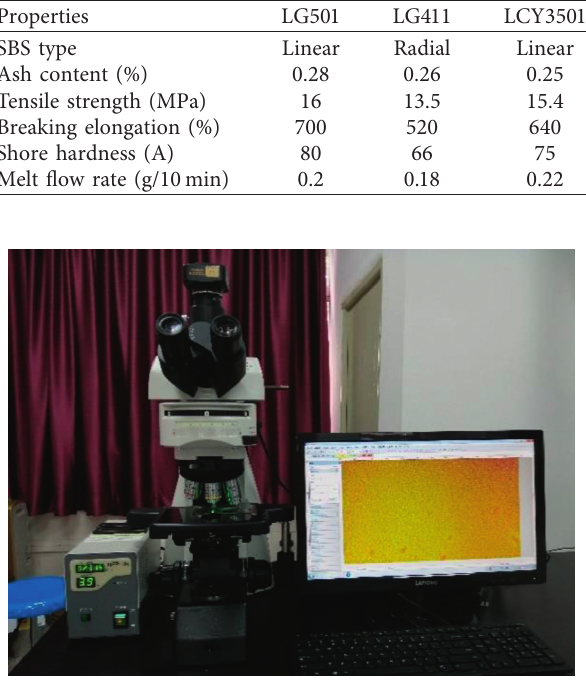
Figure 1: Fluorescence